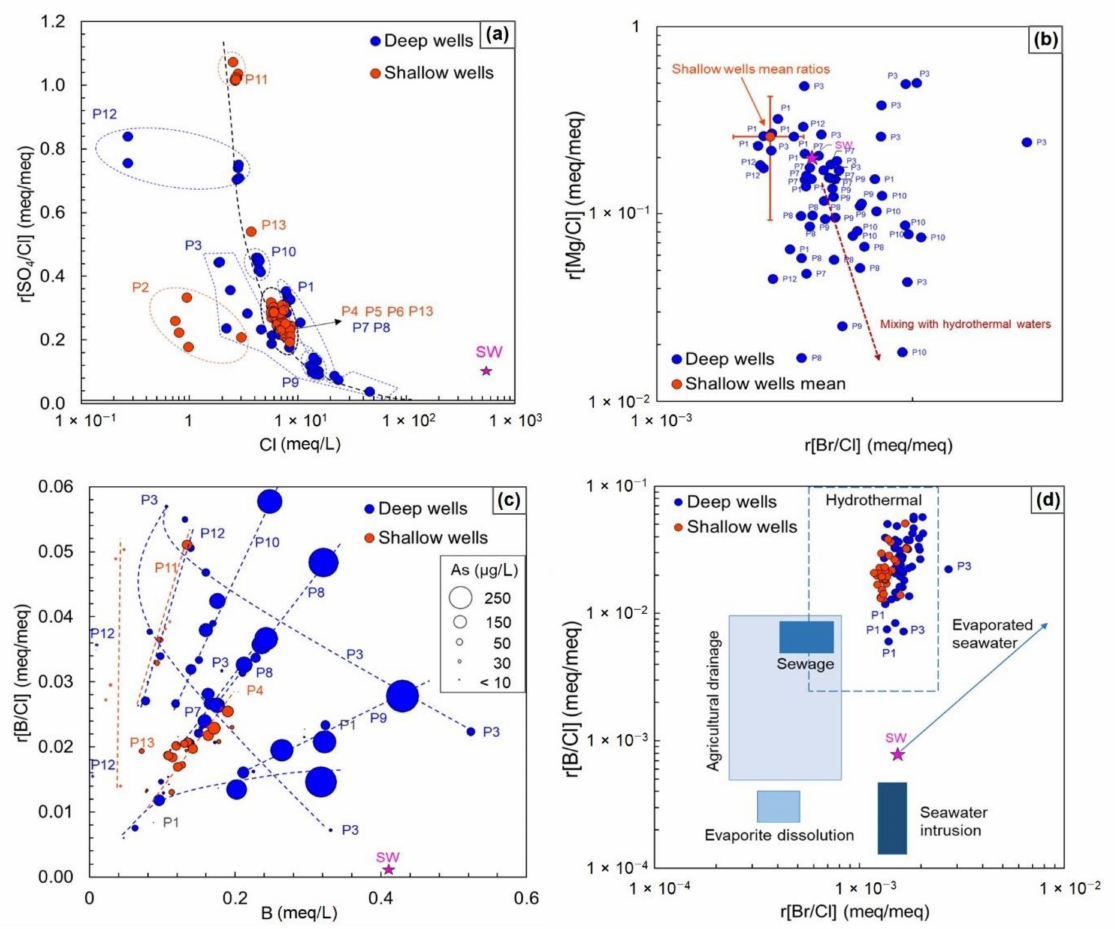
Figure 7. Plots of ( a ) r[SO 4 / Cl] vs. [Cl], ( b ) r[Mg / Cl] vs. r[Br / Cl], ( c ) r[B / Cl] vs. [B] and ( d ) r[B / Cl] vs. r[Br / Cl] in shallow (red circles) and deep (blue circles) wells; the pink star represents seawater (SW). In ( c ), the area of the circles is proportional to [As] and the dashed lines represent trends of the values measured in each well. In ( d ), the boxes represent the sources values (i.e., agricultural drainage, sewage, hydrothermal waters, etc.) (after